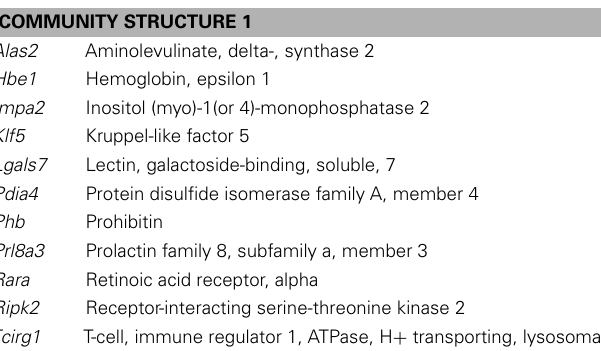
Table 2 | Gene symbols and corresponding gene names of the two community structures that constitute the kernel layer of the hypoxia-associated genetic core network.